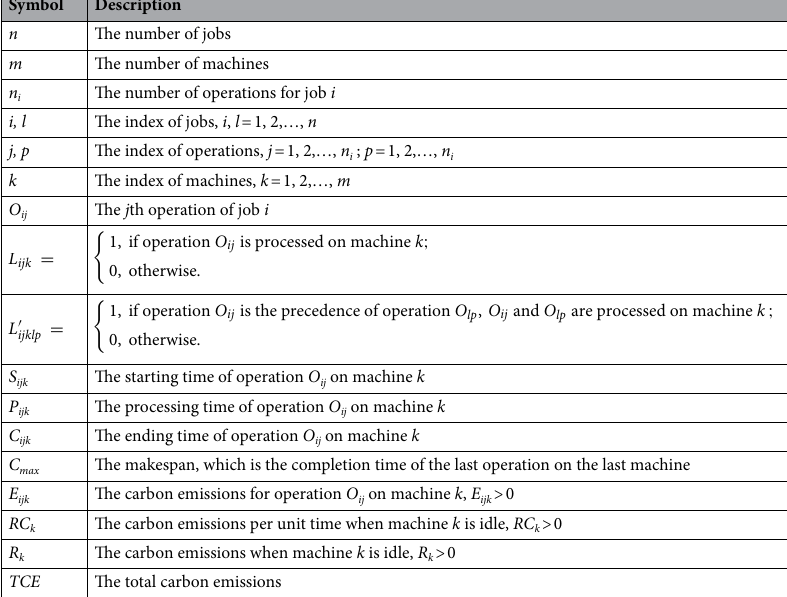
Table 1. Main symbols and